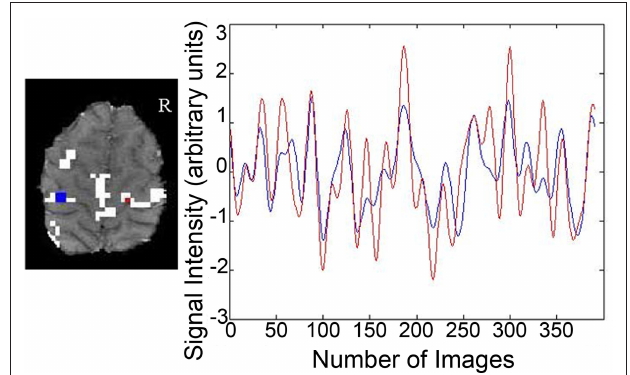
FIguRe 1 | Connectivity data from a representative participant. The seed region and corresponding time course for a single participant are depicted in blue. Voxels having correlation strength above threshold are shown in white. The time course for a suprathreshold voxel and the corresponding voxel are shown in